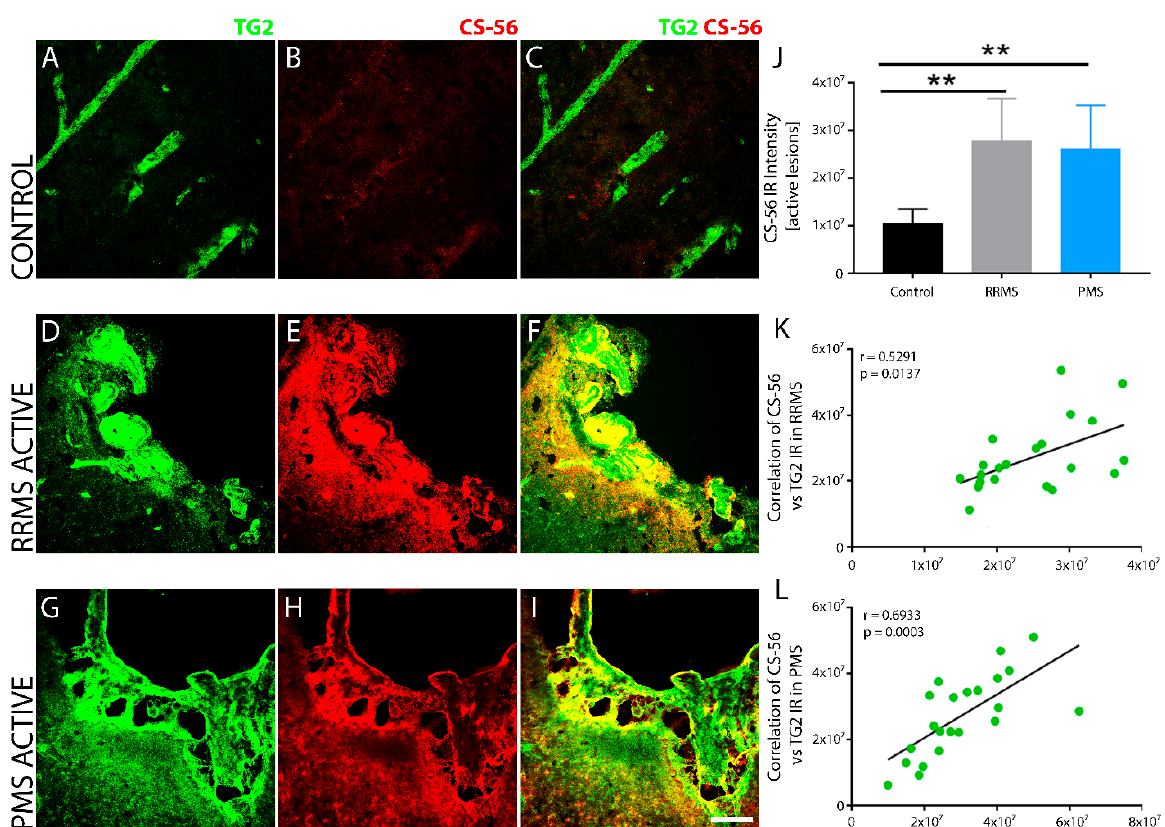
Figure 7. CSPG levels were upregulated with increased TG2 IR within active sclerotic lesions of both RRMS and PMS brain tissues. TG2 immunofluorescence in control, non-MS brain tissue exhibited restricted basal expression ( A ), which was largely found within blood vessels and overlapped with very low levels of CSPG immunoreactivity (CS56 antibody, B , C ). Conversely, there was robust and overlapping accumulation of TG2 and CSPG, both within the core and the edge of sclerotic plaques in brain tissue from both RRMS ( D – F ) and PMS ( G – I ). High-magnification image scale bar represents 50 µ m. Quantitative measurement of total fluorescence intensity of CS-56 immunoreactivity indicated a significant increase in the levels of CSPG in both RRMS ( n = 6) and PMS ( n = 5) sclerotic plaques ( J ) compared to the low expression levels measured in non ‐ MS brain tissue ( n = 6). No significant difference was observed in CSPG immunoreactivity within the active sclerotic lesions between RRMS and PMS. Statistical significance is indicated by a ** p < 0.01; determined using a 1 ‐ way analysis of variance and post hoc Tukey test. Error bars are mean ± SD. CSPG expression showed a significant positive correlation with TG2 IR in active lesions after both RRMS ( K ) and PMS ( L ). The correlation between the expression levels of CS ‐ 56 and TG2 IR in the lesions from all the patients in each of the two forms of MS is shown in ( K , L ). The p ‐ value determined by linear regression and Pearson correlation coefficient (r) is indicated for each of the analyses.